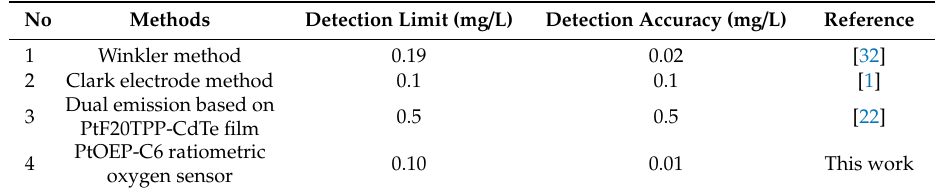
Table 1. Comparison of detection limit and accuracy of di ff erent